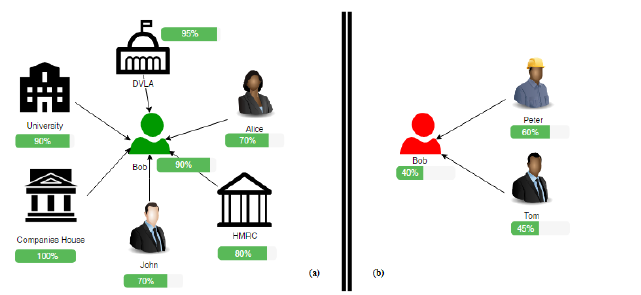
Figure 3. (a) Real Bob with several trusted verifiable claims on the left and (b) imposter Bob with few claims about his identity. If Bob is proved to be a malicious person, both Tom and Peter risk losing their score too, hence they will have to vote for the real Bob in order to preserve their own identity score